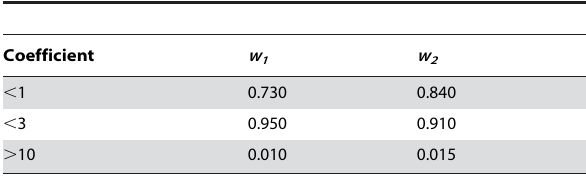
Table 1. Distribution of metagene coefficients: Leukemia data, k =